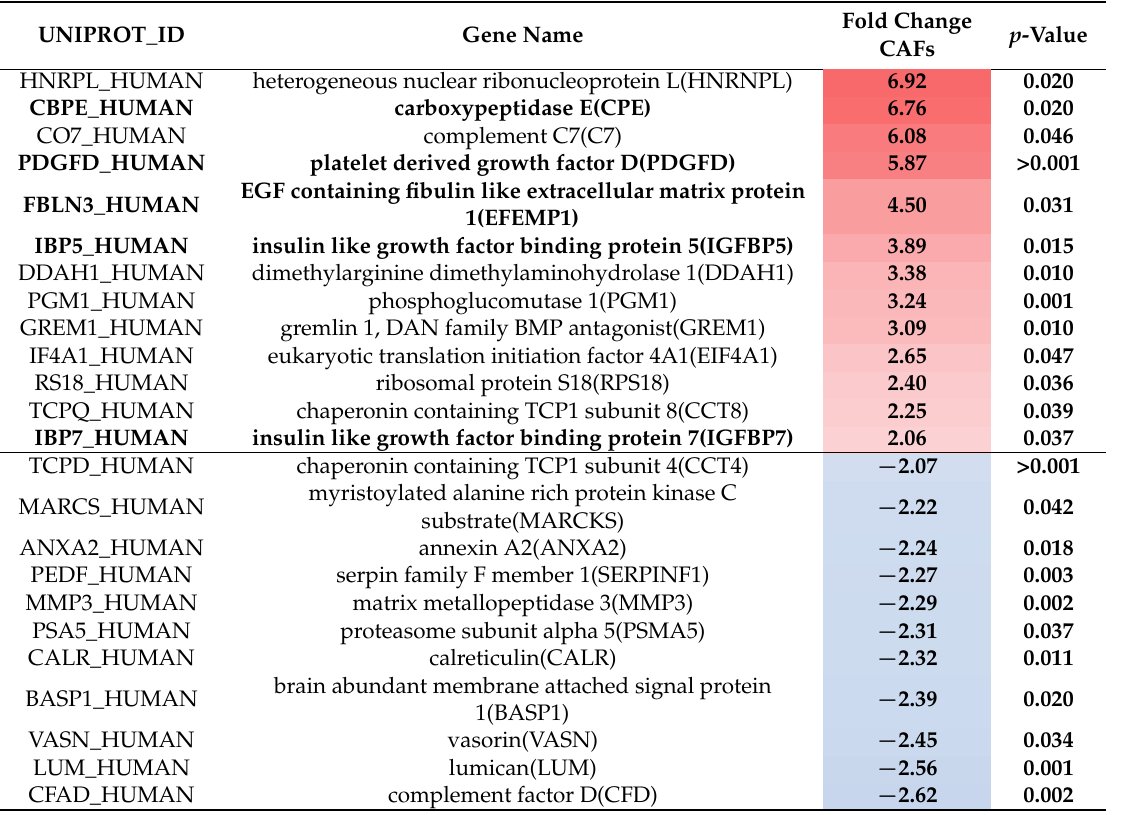
Figure 4. Mass Spec analysis of extracellular proteins differentially secreted by CAFs versus NFs. ( A ) Volcano plot showing the global secretome changes, illustrating fold change (log base 2) and p -value ( − log base 10), between CAFs and NFs. Horizontal bars represent the significance p = 0.05, p = 0.01 and p = 0.001 (proteins under horizontal bar of p = 0.05 did not reach significance). Vertical bars represent the proteins with a fold change higher than 2 or − 2; ( B ) Heatmap represents the changes in the growth factors related-proteins found in the secretome. Three independent experiments are shown; red indicates fold changes >0 and blue indicates fold changes <0. Table 1. Proteins differentially secreted in CAFs versus NFs